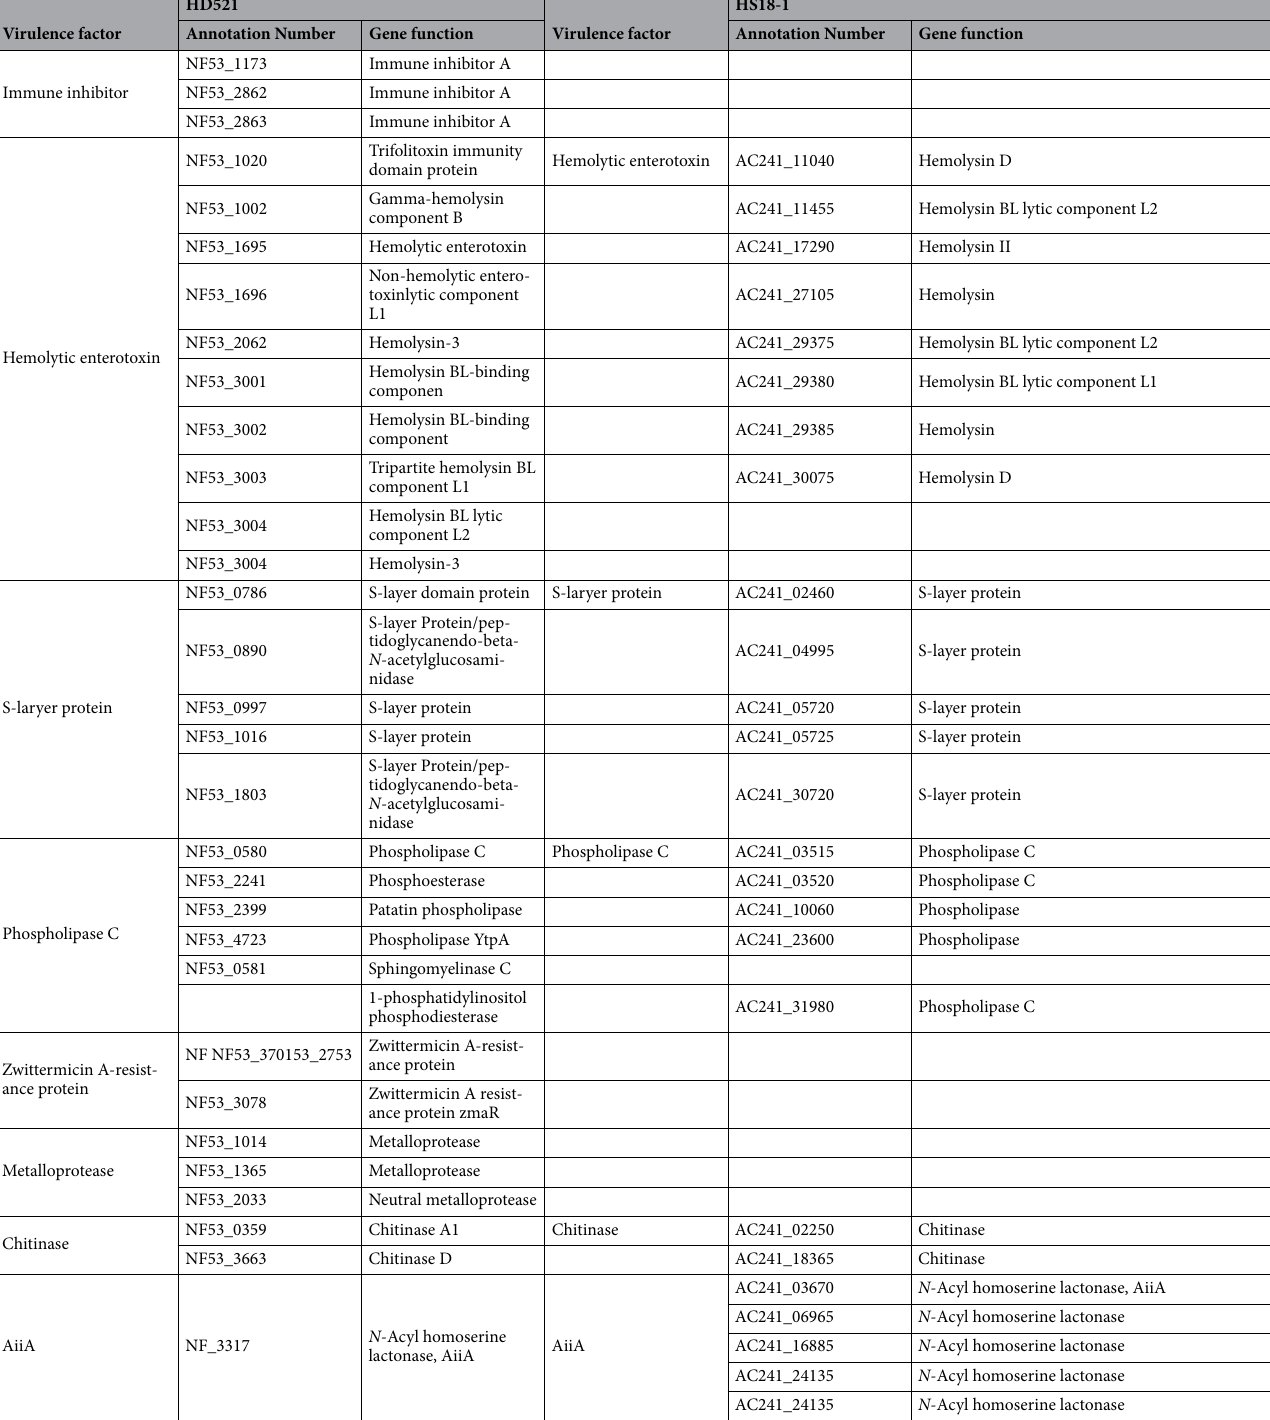
Table 2. Virulence factors of Bacillus thuringiensis strain HD521 and